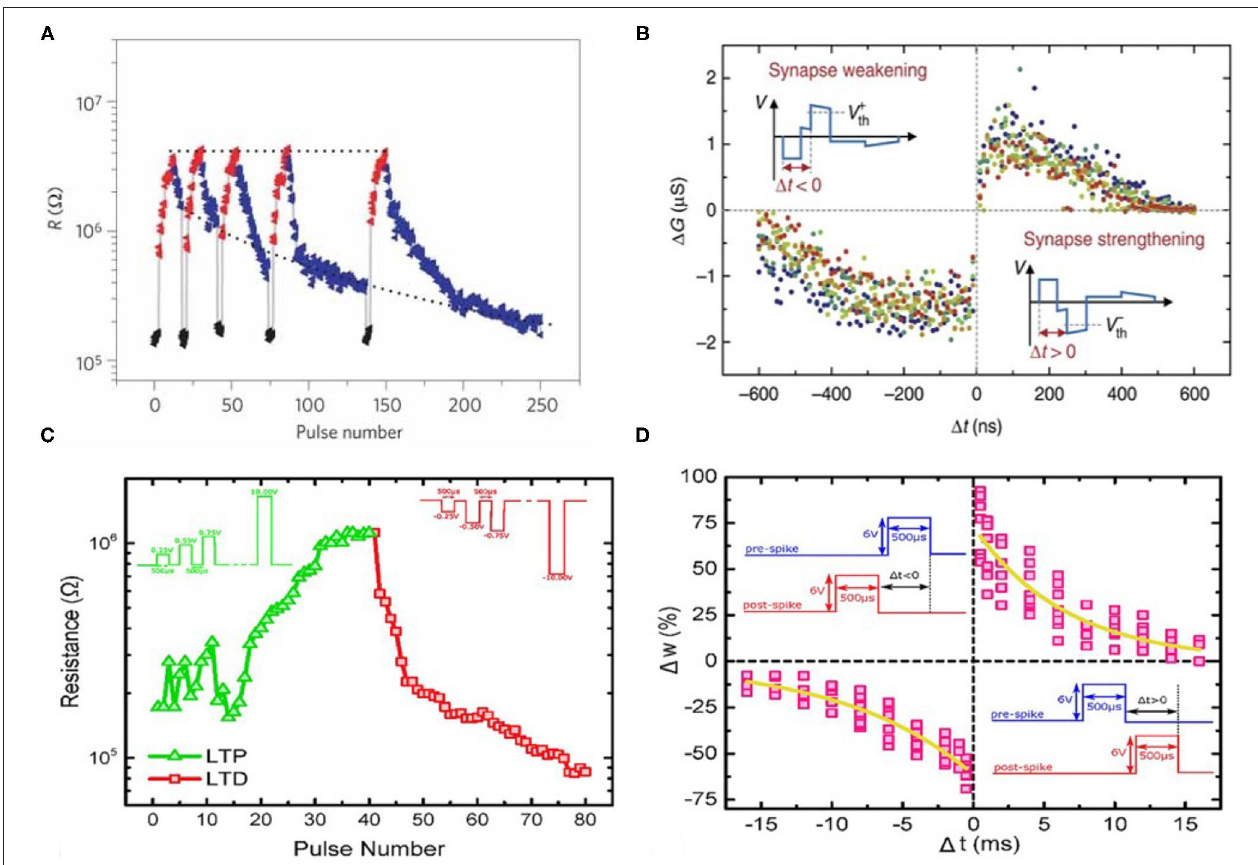
FIGURE 10 | (A) Demonstration of synaptic potentiation and depression in a BaTiO 3 -based FTJ. Figure reproduced with permission from Chanthbouala et al. Nat. Mat. 11, 860–864 (2012) Copyright 2012 Springer Nature. (B) STDP demonstration in BaFeO 3 based FTJ. Figure reproduced from Boyn et al. Nat. Comm. 8, 14736 (2017). Copyright 2017, Authors, licensed under a Creative Commons Attribution (CC BY) license. (C) Demonstration of synaptic potentiation and depression and (D) STDP in HfO x based FTJ. Figures reproduced with permission from Yoong et al. Adv. Funct. Mater. 2018, 28, 1806037. Copyright 2018 WILEY-VCH Verlag GmbH & Co. KGaA,